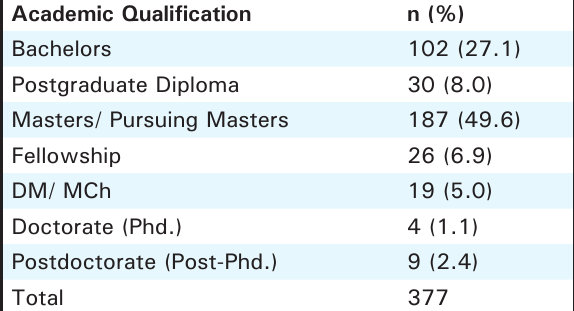
Figure 2. Distribution of specialties of medical doctors (n= 377). Table 3. Highest academic